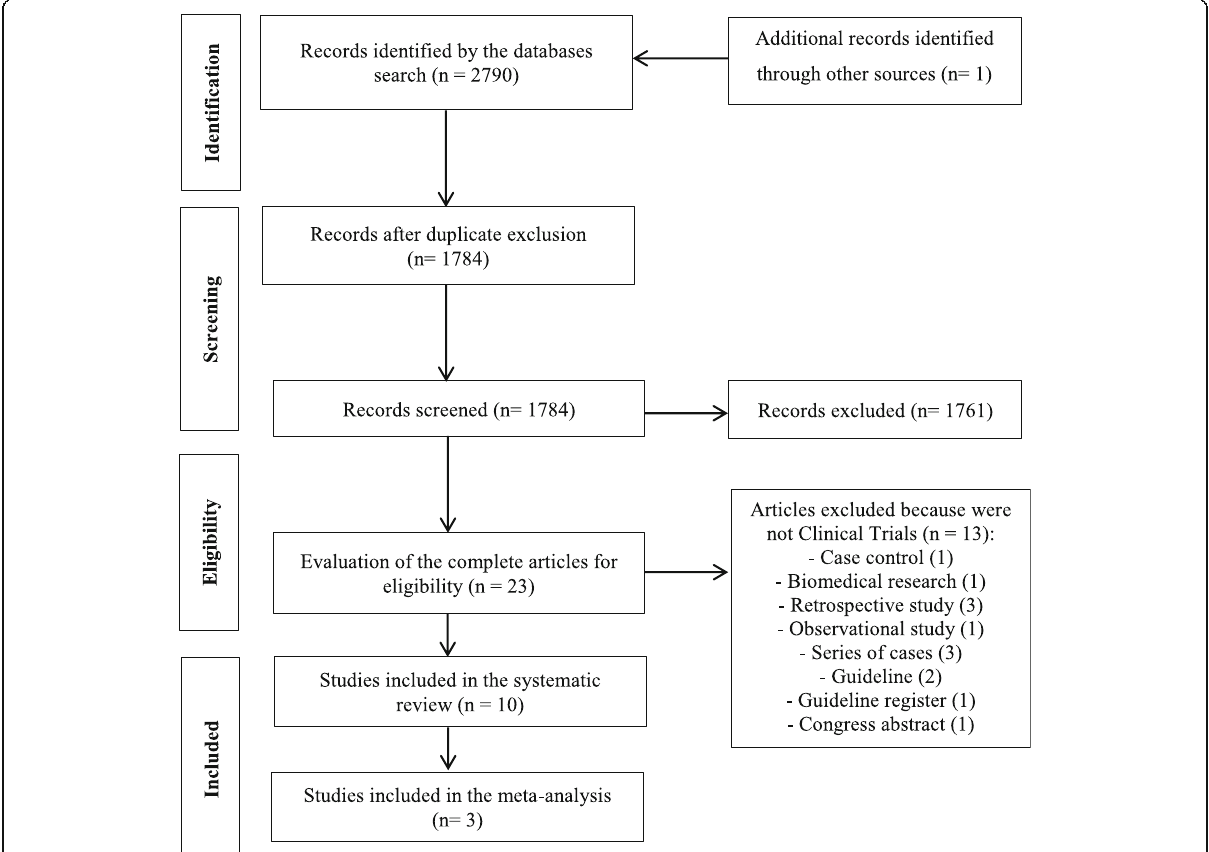
Fig. 1 Selection of manuscripts for the systematic